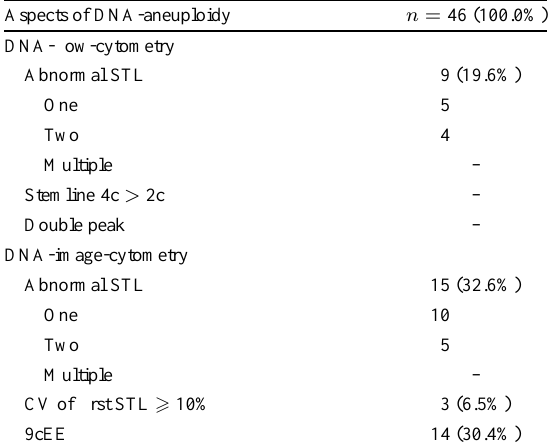
Prevalence of different aspects of DNA-aneuploidy in effusions of primary and secondary tumors of the serous membranes (DNA-flow- and -image-cytometry) (STL = stemline; CV = coefficient of varia- tion; 9cEE = 9c exceeding events) Aspects of DNA-aneuploidy n = 80 (100.0%)